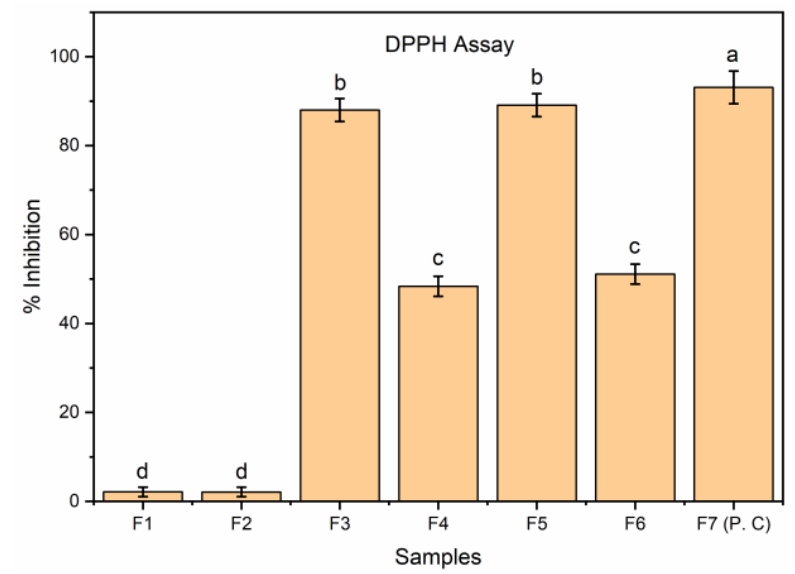
Figure 5. Antioxidant potency (DPPH) of GE-Gly blank films (F1, F2), GE-Gly-GEO films (F3, F4), GE-SA-Gly-GEO film (F5, F6), and butylated hydroxytoluene (F7) determined by DPPH method. Bars correspond to mean values ± standard variations. Bar with distinct characters (a–d) reveals substantial variation between the groups ( p < 0.05).